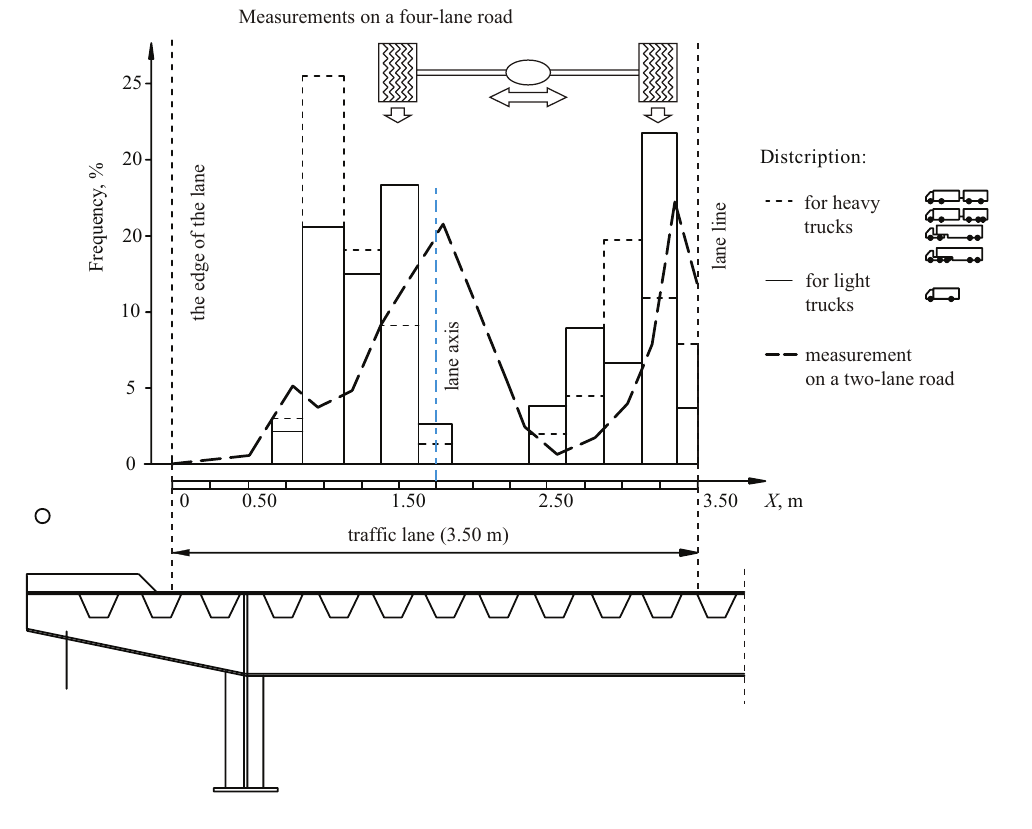
Figure 2. Frequency of appearance of tyre tracks across the width of a traffic lane (Bruls,